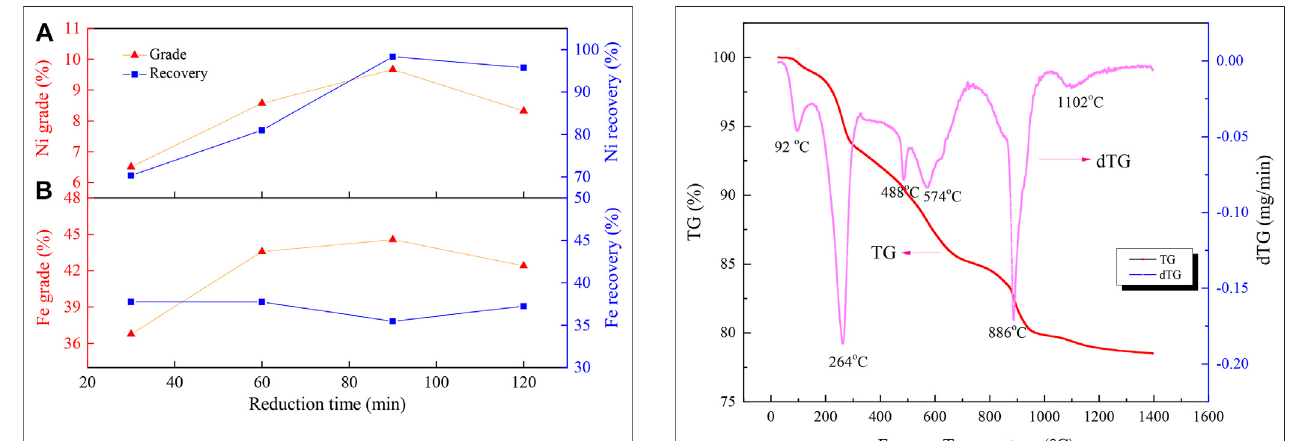
FIGURE 4 | Effect of reduction time on (A) nickel and (B) iron enrichment. Experimental conditions: Na 2 S 2 O 3 addition, 20 wt%; temperature, 1000 ° C; fl ow rateofH 2 /N 2 , 27 L/(min · kg);gasvolume fraction of H